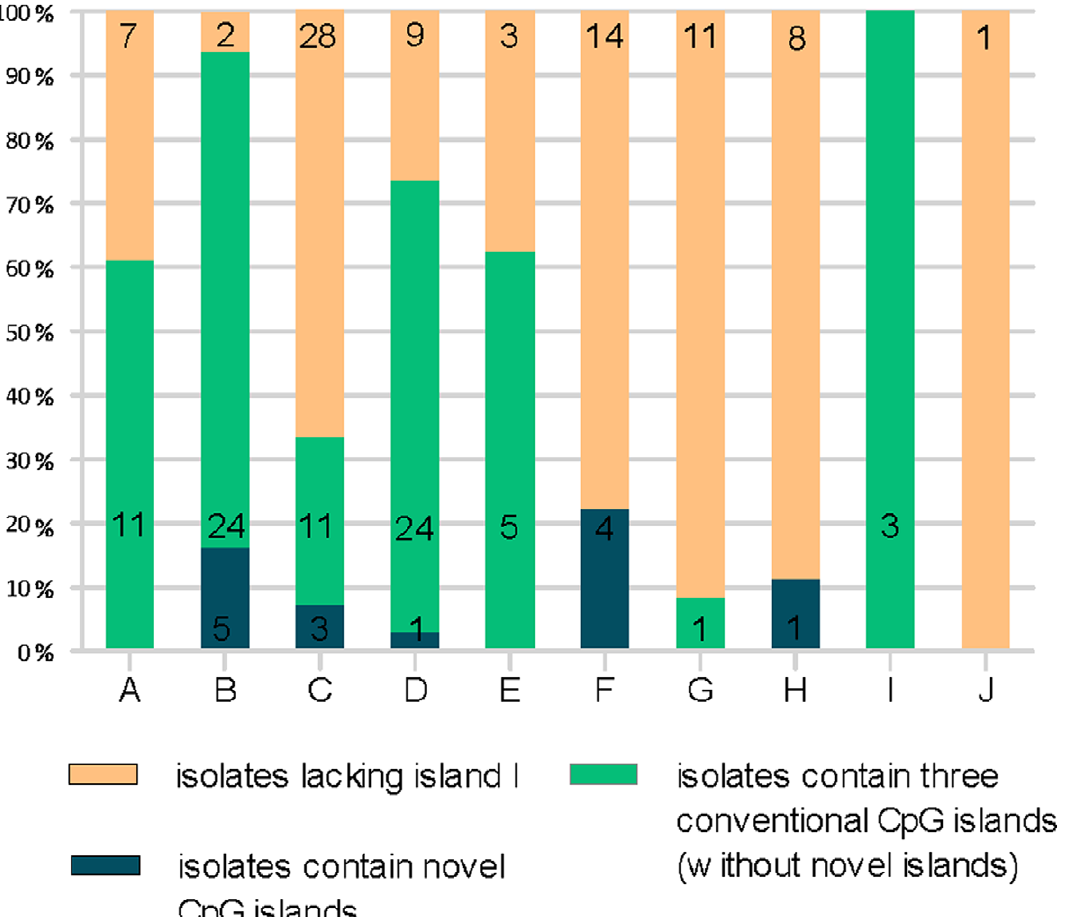
Figure 3. Number of HBV genomes without CpG island I, containing three conventional islands or novel islands among different